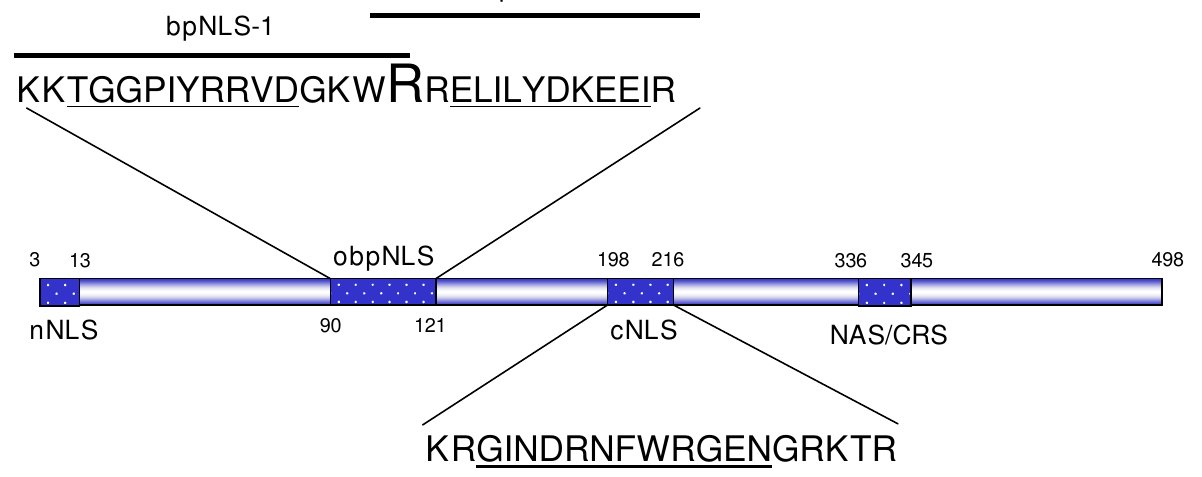
Figure 2 Schematic representation of various domains of the NP. Numbers indicate amino acid positions. nNLS: non-conventional nuclear localization sig- nal; cNLS: classical nuclear localization signal; NAS/CRS: nuclear accumulation signal/cytoplasmic retention signal; obpNLS: overlapping bipartite nuclear localization signal; bpNLS: bipartite nuclear localization signal. Critical amino acids contributing to a bpNLS motif are represented by two basic aa-rich domains (in bold) and the spacer 10 aa are underlined. Also note that the cNLS contains a slightly longer (12 aa) spacer region and thereby does not strictly qualify as a classical bpNLS by the PSORT